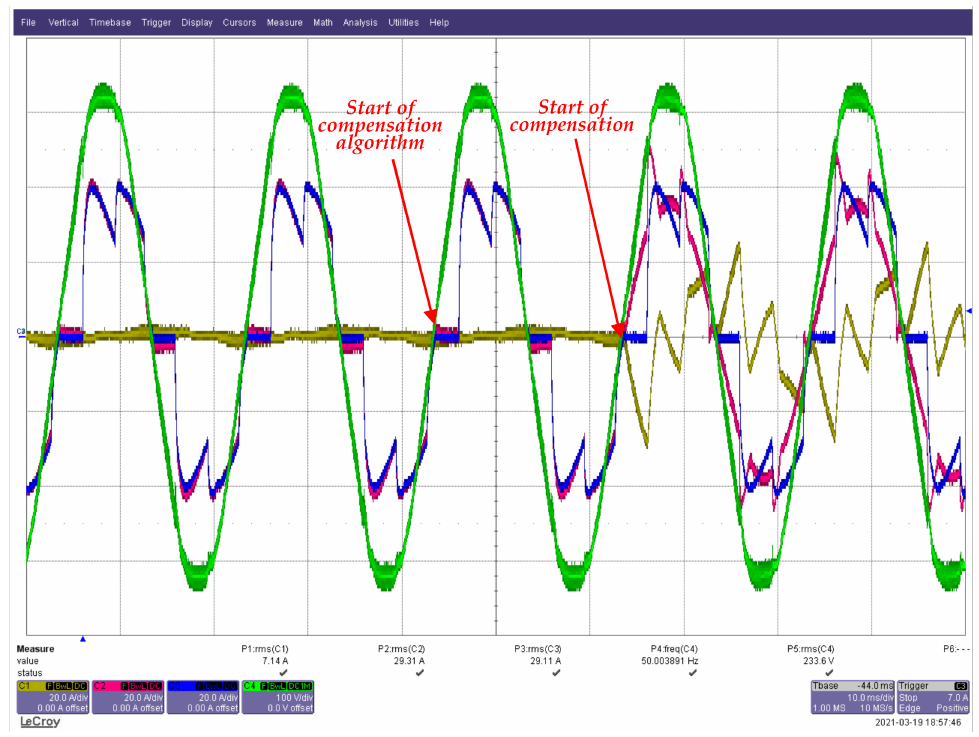
Figure 16. Experimental waveforms of the APF in transition state, line current i M1 ( t ) (red), load current i L1 ( t ) (blue), compensation current i C1 ( t ) (yellow), and line voltage u M1 ( t )